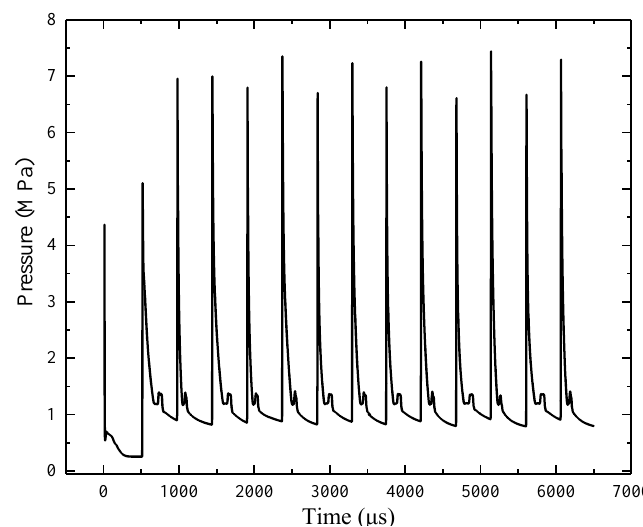
Figure 4. Changing of static pressure with time at monitoring point (127.4 mm, 0 mm, 147 mm).